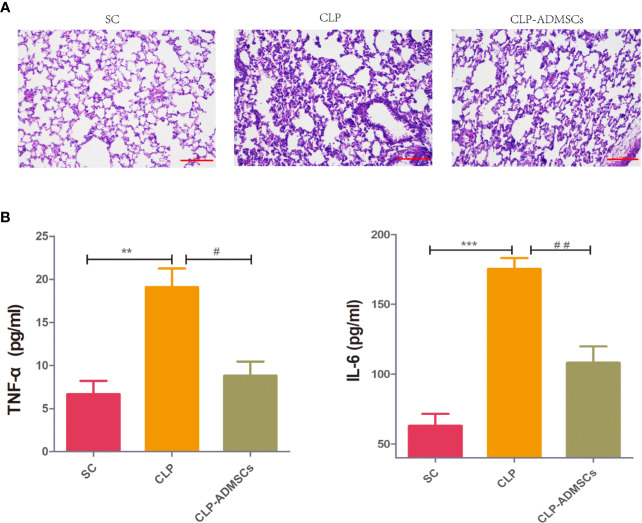
(A) Histology of the lungs of the SC, CLP, and ADMSCs groups after CLP 24h (n = 6). Hematoxylin and eosinstaining showed significantly enhanced inflammatory infiltration, edema, and bleeding in the CLP group. ADMSCs treatment improved these abnormalities (scale bar = 100 µm). H & E: Hematoxylin and eosin. (B) Effects of ADMSCs treatment on the systemic inflammatory response in CLP rats (n = 6). ELISA was used to detect plasma IL-6 and TNF-α concentration in each group at 24 h. *Compared with the SC group, #compared with the CLP group; *, #P < 0.05; **, ##P < 0.01; ***, ###P < 0.001.